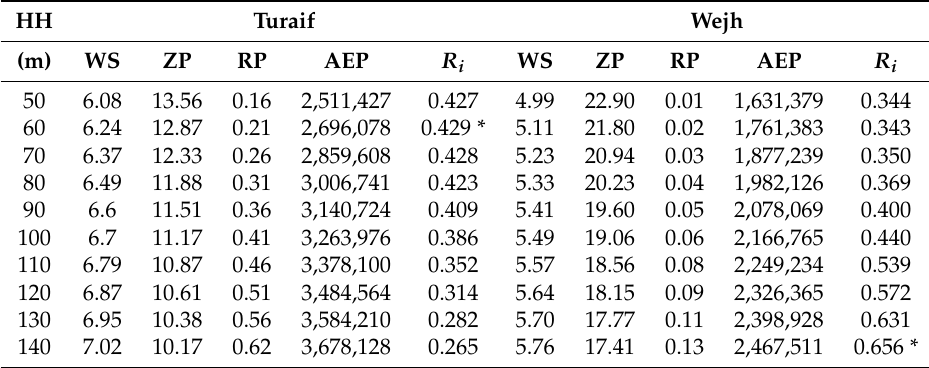
Table A1. TOPSIS analysis for turbine Acciona AW 70/1500 Class I. The best choice for each site is marked with an asterisk.